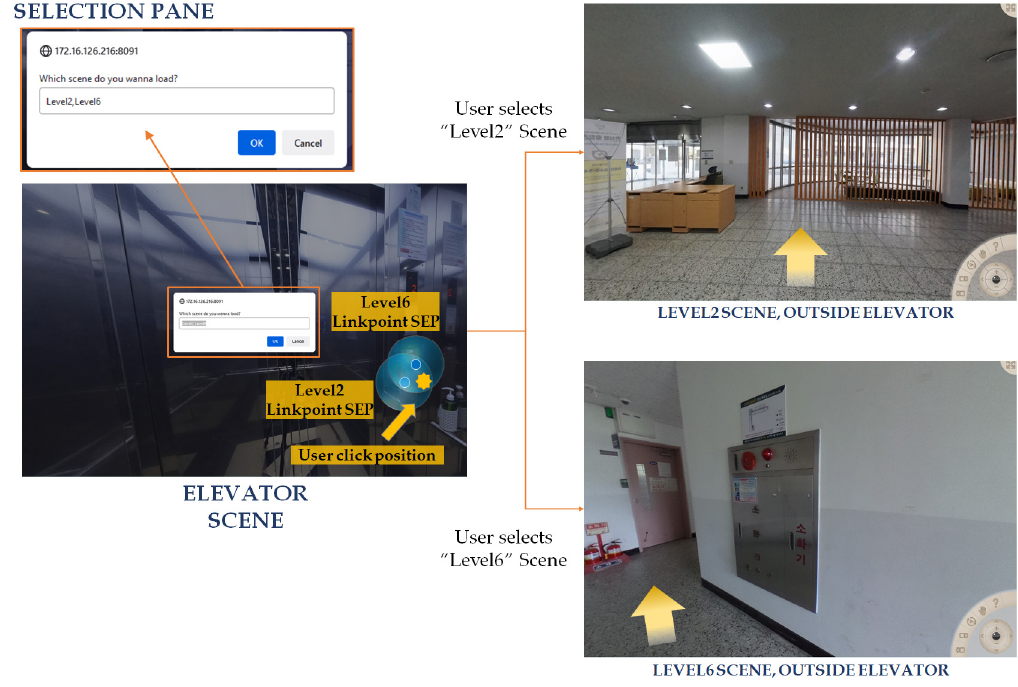
Figure 16. Implementation of space identification on the images through a double ‐ click action.